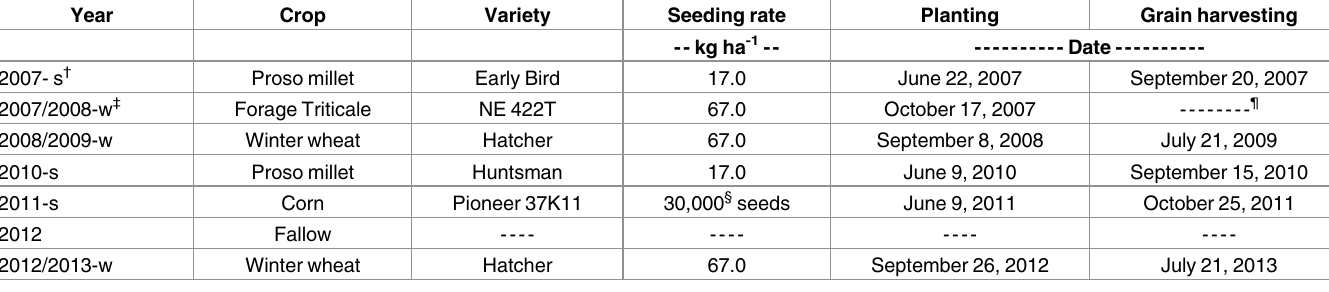
Table 1. Crop description and field operation information since the initiation of the study in fall 2006 to